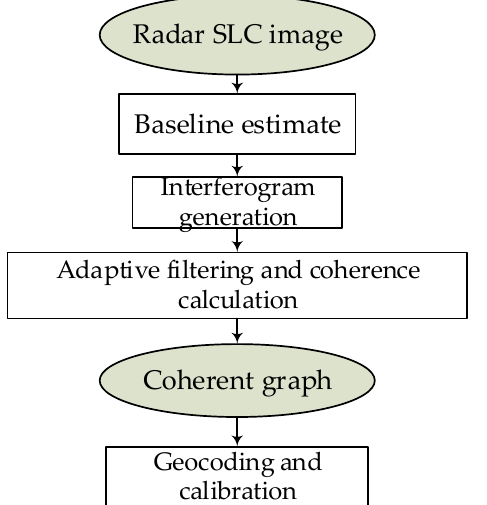
Figure 5. InSAR processing flow.